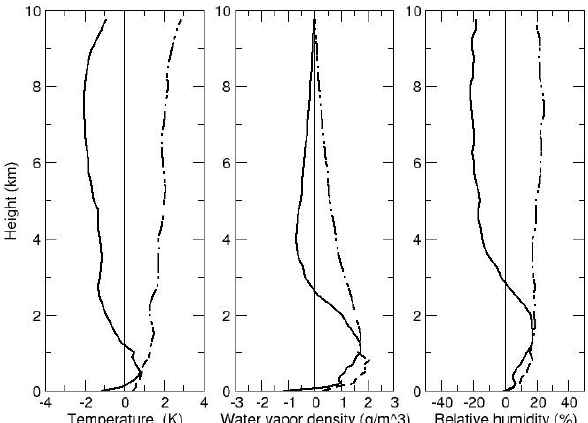
Fig. 14. Mean bias (solid line) and standard deviation (dashed line) of the differences between retrieved (statistical retrieval) and radiosonde-measured profiles of temperature, vapor density and rel- ative humidity ( N = 112). Data were collected 4 times a day at the AMF1 during October